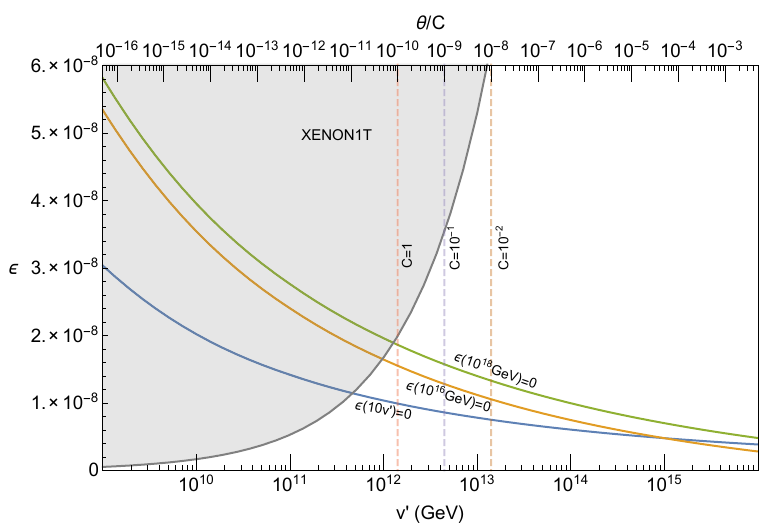
Figure 2 . The prediction for the kinetic mixing parameter (cid:31) as a function of v , for three values of (cid:31) , the shaded region is excluded by the direct detection limit of the cutoff of the theory. If DM is e (cid:31) XENON1T. For various values of the coupling C , defined in (3.5), the present limit on the neutron electric dipole moment excludes the region to the right of the vertical